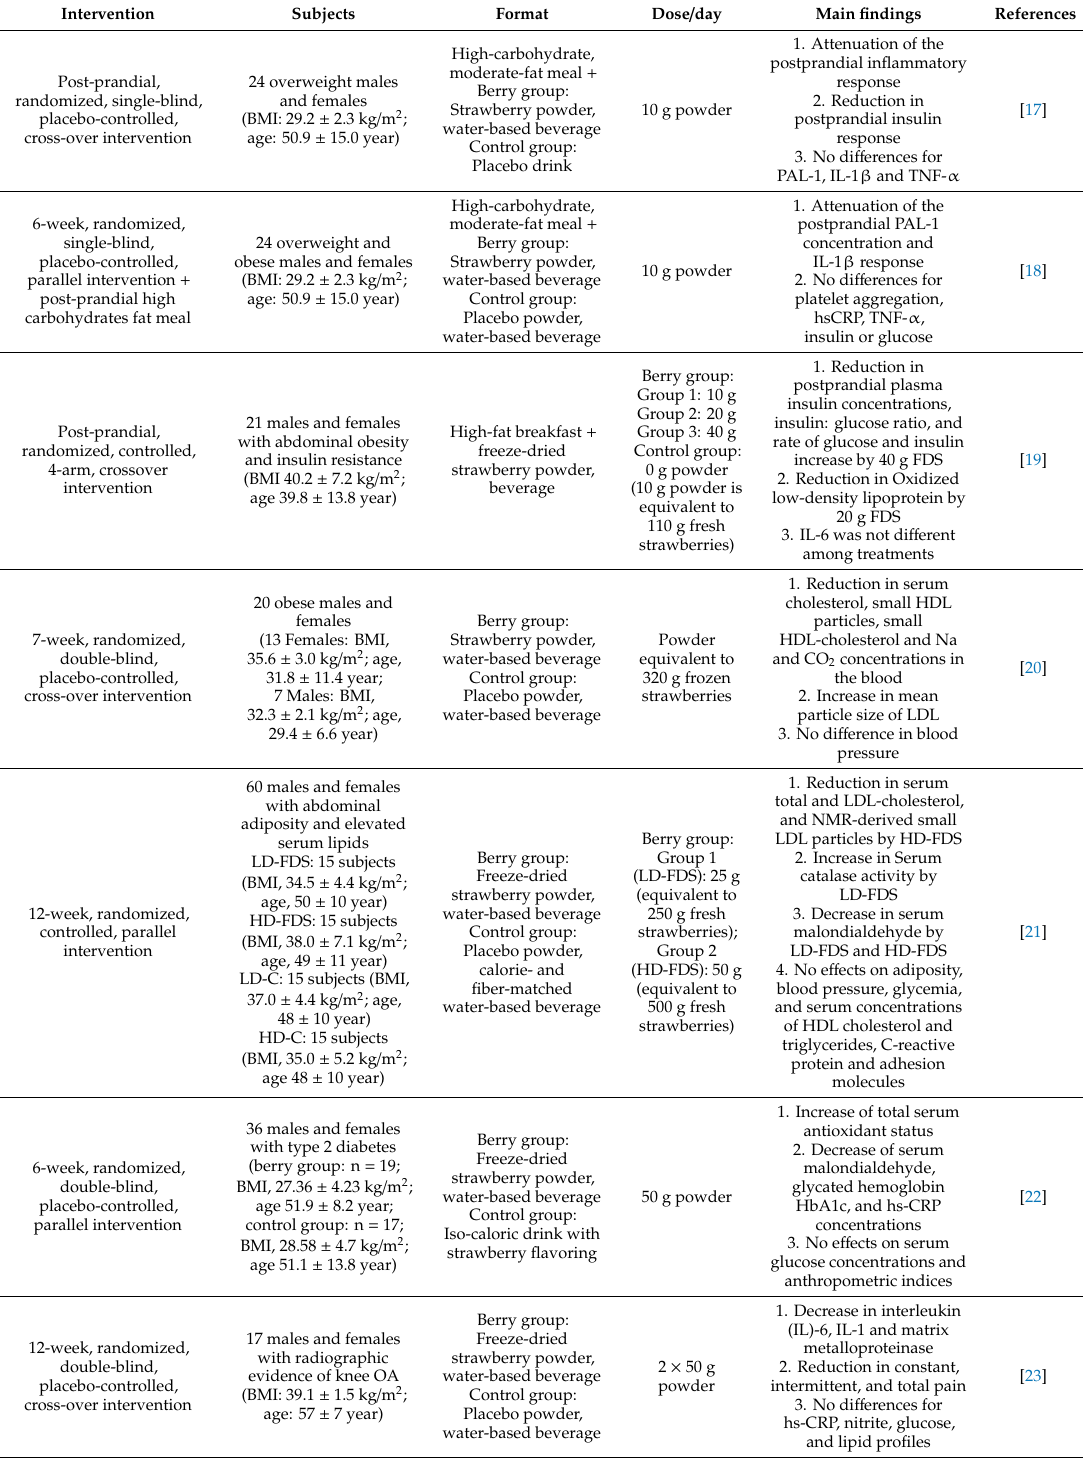
Table2. Effectofstrawberryconsumptiononinflammation,cardiovasculardiseaseandmetabolicsyndrome. Intervention Subjects Dose /